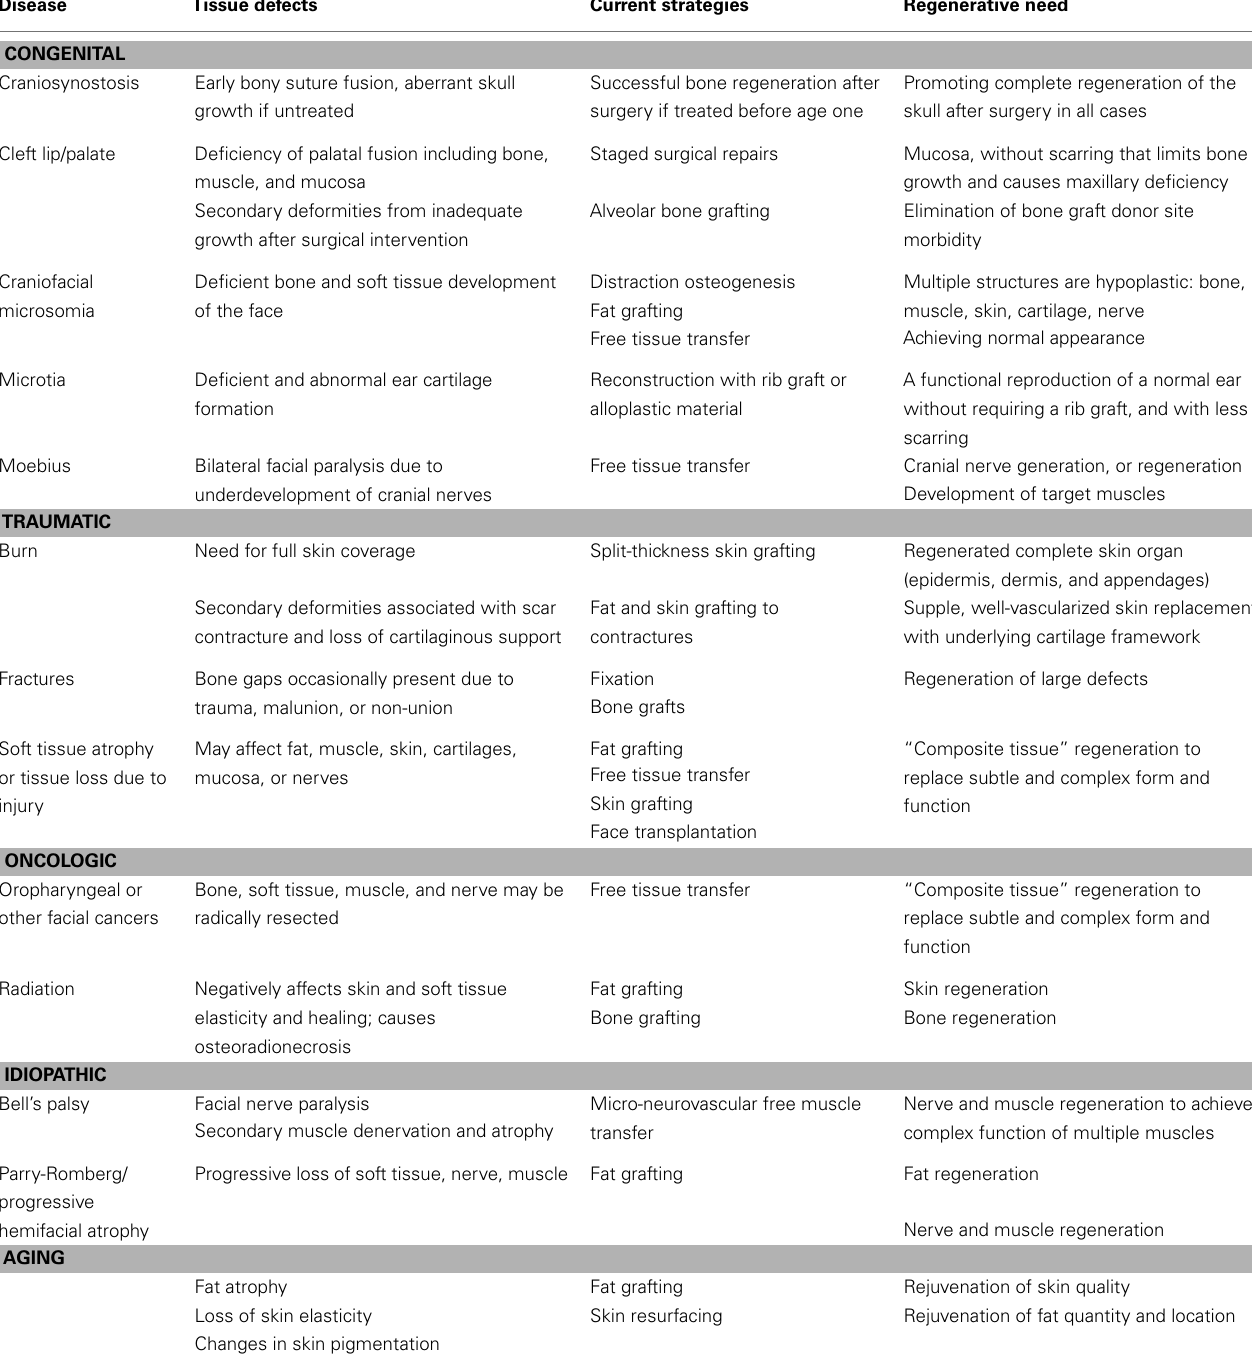
Table 1 | Examples of craniofacial disorders and corresponding unmet “regenerative”